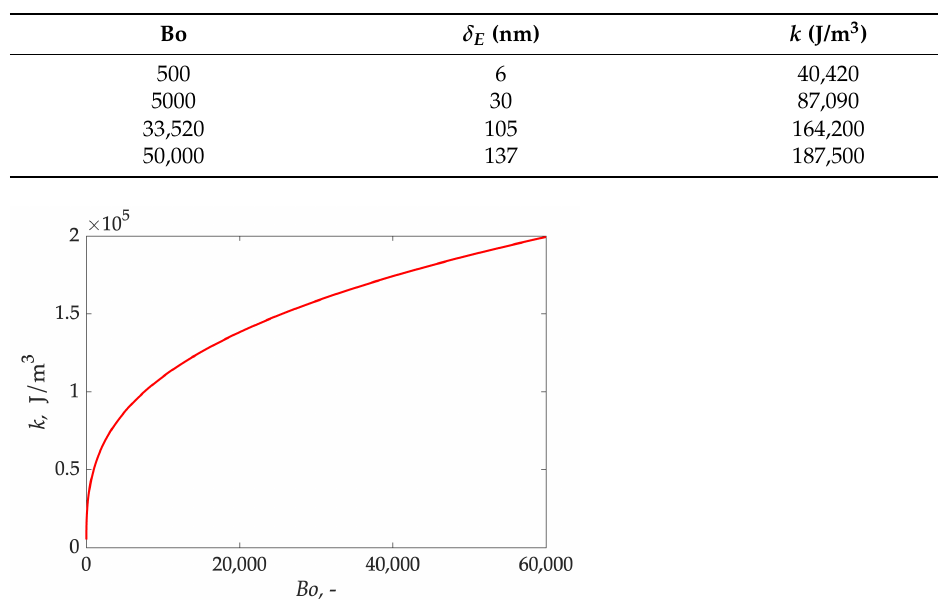
Table 2. Equilibrium overlap and cohesion energy density for different values of the Bond number.